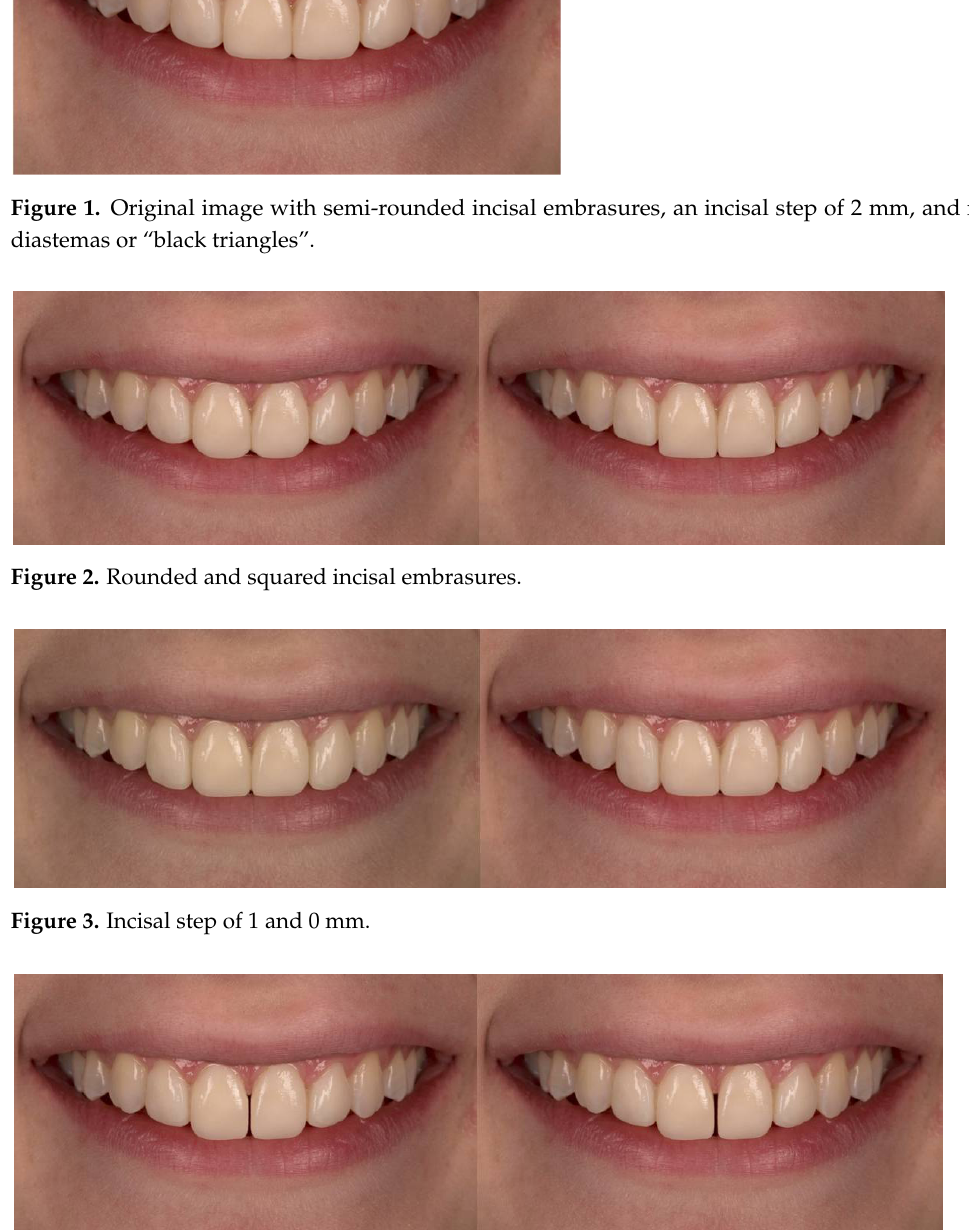
Figure 4. Midline diastema of 0.5 and 1 mm.